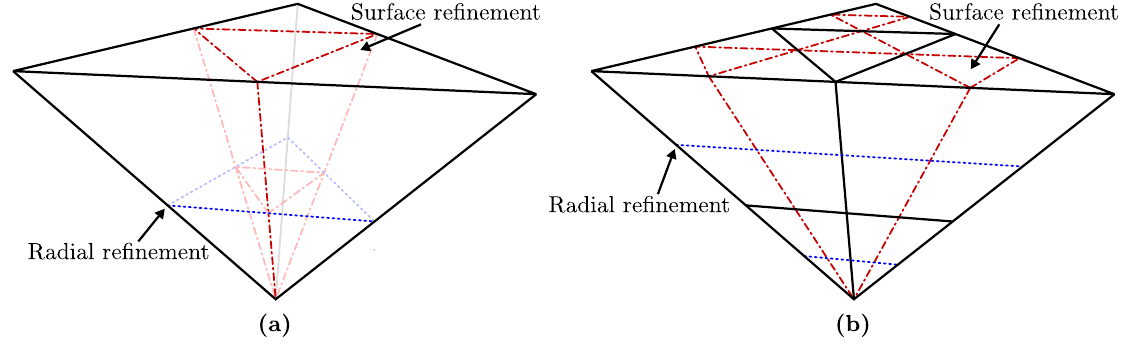
Figure 4. Regular prismatoid refinement as applied to a single pyramid cell ( a ) once and ( b ) twice.